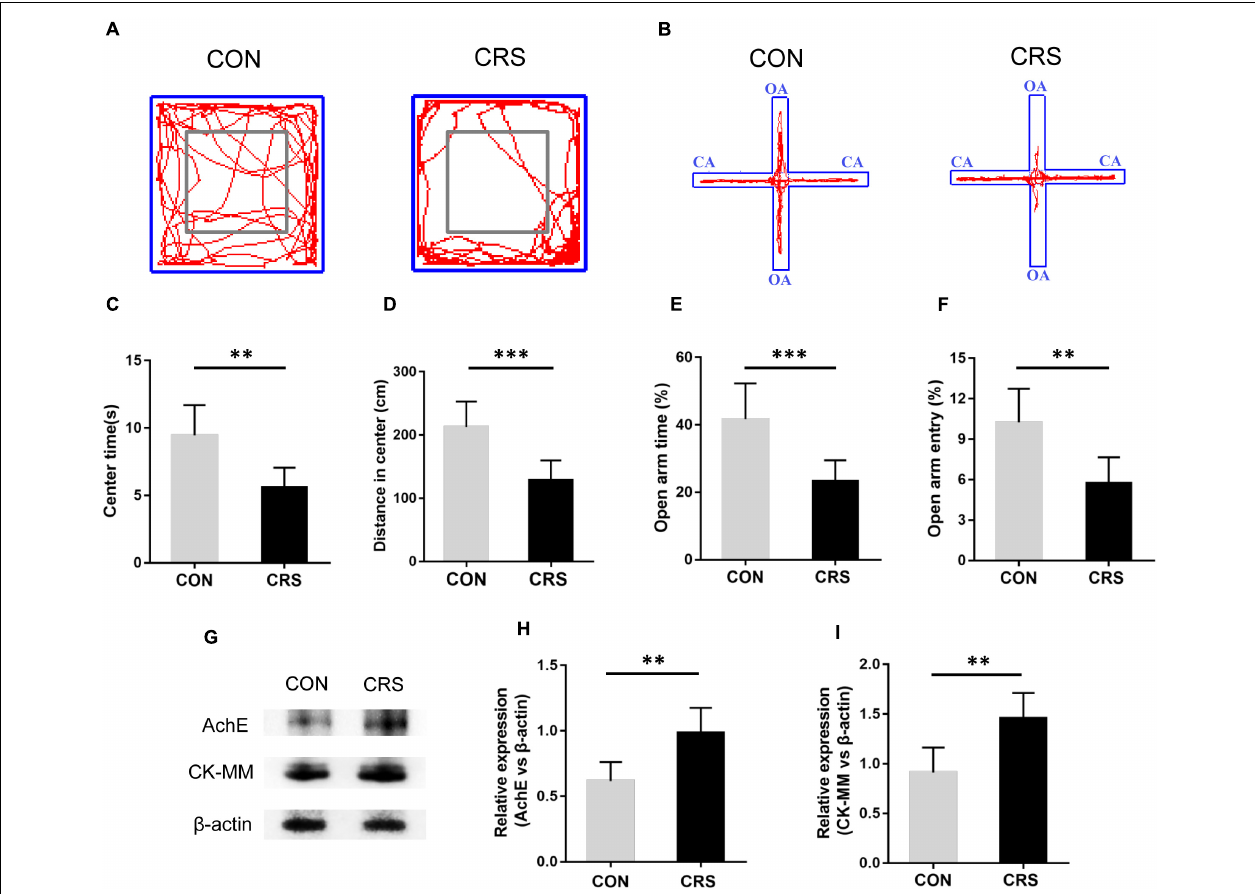
FIGURE 1 | Effect of CRS on behavioral changes and masseter AChE and CK-MM expression. Representative movement trials of mice from the CON and CRS groups in the OF (A) and EPM (B) tests ( n = 6/group). The gray square frames represent the center area in the OF. OA: open arm. CA: closed arm. In the OF test, the time spent in the center area (C) and the distance moved in the center area (D) were significantly different between the CON and CRS groups. In the EPM test, the percentage of the open-arm retention time (E) and open-arm entries (F) were significantly different between the CON and CRS groups. (G) Western blotting analysis displayed the protein levels of AChE and CK-MM in the masseter of mice ( n = 5/group). Statistical comparison of the blotting data revealed that AChE (H) and CK-MM (I) expression in CRS mice was significantly higher than that in CON mice. ∗∗ P < 0.01, ∗∗∗ P <